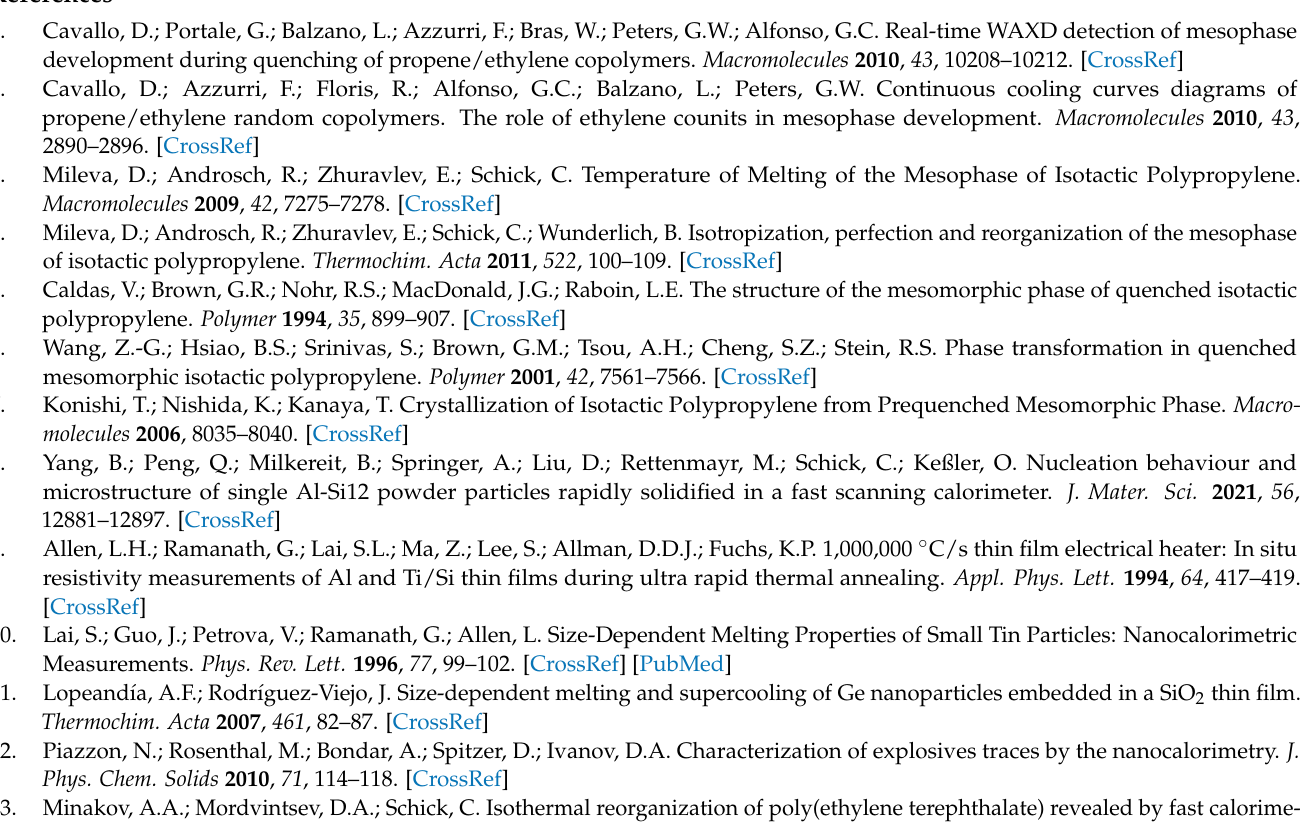
Figure S2: Decomposed 1D WAXS curve for CR_M1 morphology; Figure S3: Heating endotherms of iPP mesophase formation at rates between 40 and 2000 K s − 1